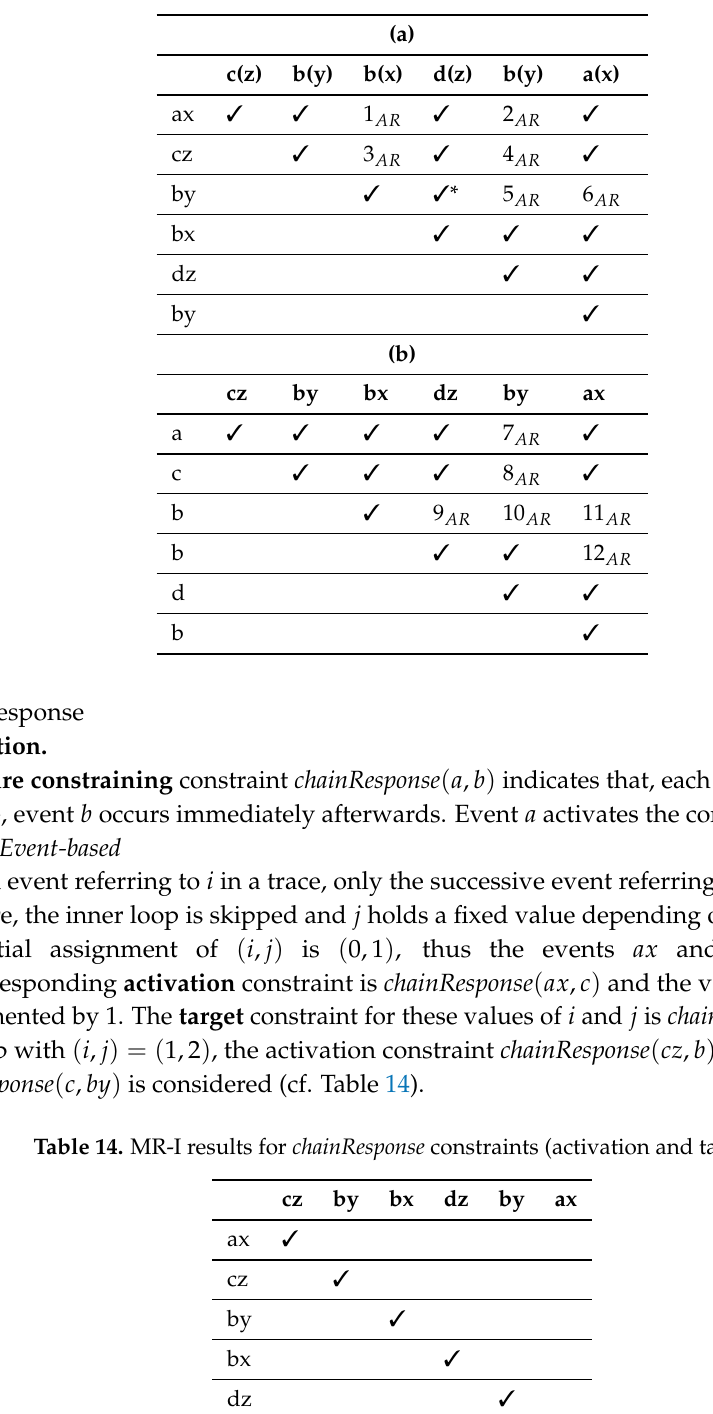
Table 13. MR-I results for alternateResponse constraints: ( a ) activation; and ( b ) target.